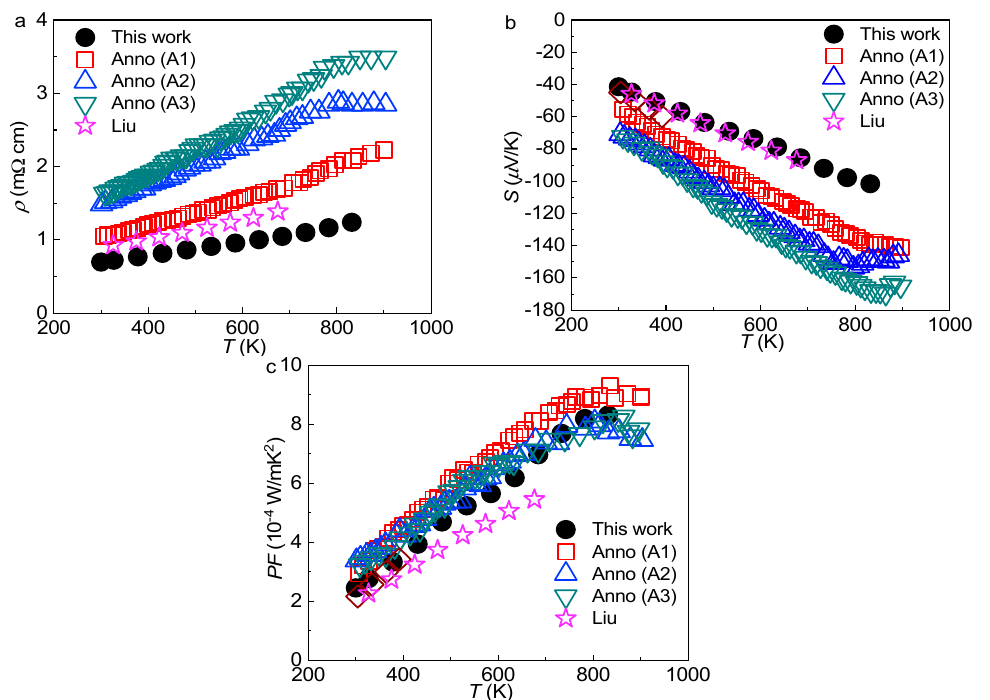
Figure 8. Temperature dependent ( a ) electrical resistivity ρ , ( b ) Seebeck coefficient S , and ( c ) power factor PF for the L sample. Comparisons are made with the data from different sources: open red squares represent Ba 7.65 Ga 14.51 Si 31.84 from Ref. [46]; open blue triangles represent Ba 7.60 Ga 14.78 Si 31.63 from Ref. [46]; open green inverted triangles represent Ba 7.79 Ga 14.81 Si 31.40 from Ref. [46]; purple stars represent Ba 7.5 Cu 0.8 Si 30.7 Ga 14.4 from Ref. [50]. According to the Zintl counting scheme, we estimated the charge carrier concentrations for all selected compounds by n 1 = 2 x Ba − 3 y Cu − 1 z Ga , where x Ba , y Cu , and z Ga are the content for Ba, Cu, and Ga in at./f.u., respectively. The prefactor is the electron number (valence electrons) that the corresponding atom can provide or accept. Here we fixed the Ba content x Ba as 8 at./f.u. (both cages are assumed to be fully filled) though the EDX content could be less in some samples. The results are given in Table 3. We also estimated the charge carrier concentration by the temperature dependent Seebeck coefficient S ( T ) using the equation: